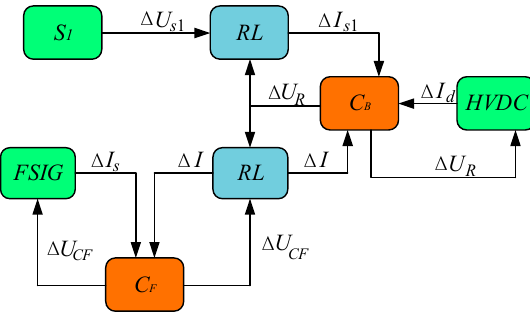
Figure 6. Interfaces between the subsystems.